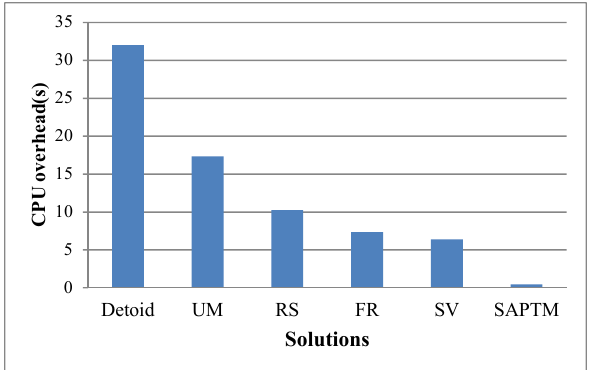
Figure 12. Comparison results of SAPTM with sketch-based solutions (CPU overhead).